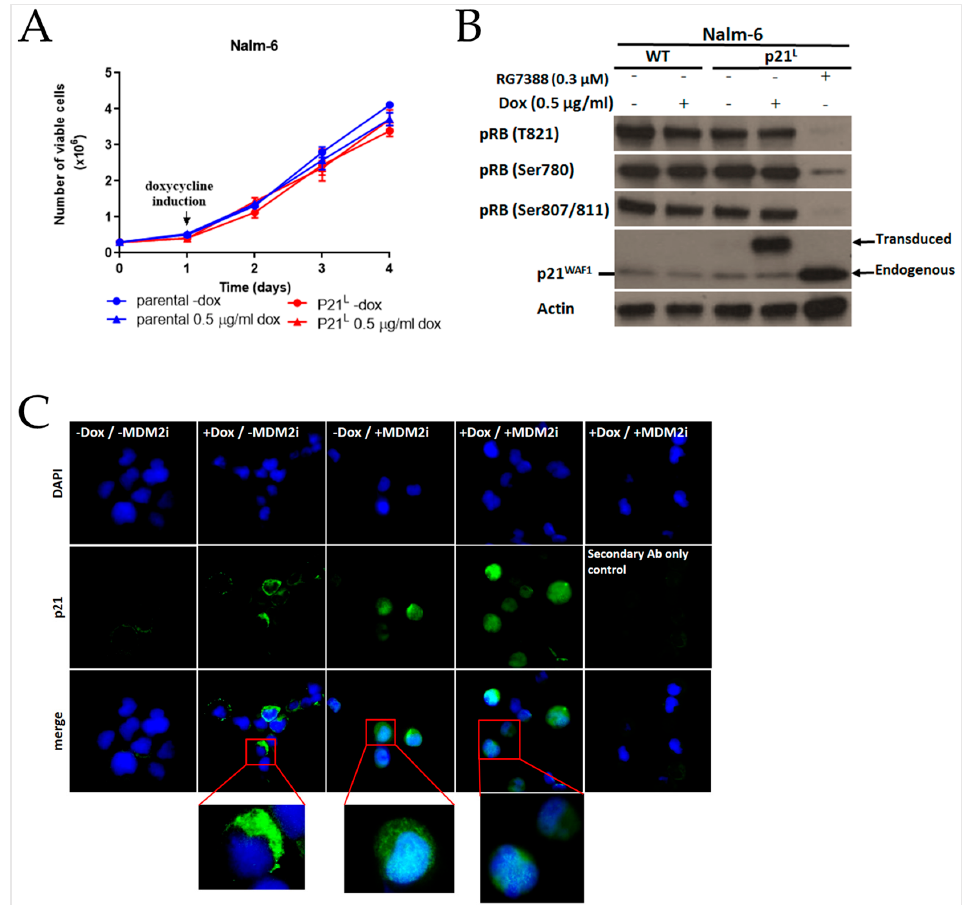
Figure 3 . High molecular weight p21 L intron-retained isoform with an alternative C-terminus loses its nuclear localisation and consequently its CDK inhibitory activity. ( A ) Growth curves of Nalm-6 parental and Nalm-6–p21 L (transduced) cells with 0.5 µg/mL or without doxycycline (-dox) in the medium. The number of viable cells was assessed by trypan blue exclusion. Error bars show the mean ± standard error of the mean (SEM) of three independent counts of viable cells observed under trypan blue exclusion assay. ( B ) Western blots of parental Nalm-6 and Nalm-6–p21 L (trans- duced) either noninduced or induced with 0.5 µg/mL doxycycline for 24 h, showing the expression of the intron-retained variant of p21 in the Nalm-6–p21 L transduced cells. MDM2 inhibitor RG7388 (0.3 µM) was used to induce endogenous wild-type p21 WAF1 . RB phosphorylation was suppressed by the induced endogenous p21 WAF1 , but not by the transduced p21 L isoform. Actin was used as a loading control. ( C ) The aberrant p21 L isoform was unable to localize to the nucleus. RG7388 was used to induce endogenous p21, which showed nuclear localisation. Twenty-four hours after doxycycline and RG7388 administration, cells were fixed on slides for immunofluorescence staining with DAPI (blue fluorescence) and anti‑p21. Alexa Fluor 488 ® ‑conjugated anti‑mouse secondary antibody (green fluorescence) was used as a secondary antibody. Fluorescent pictures of each signal, together with the merged images, are